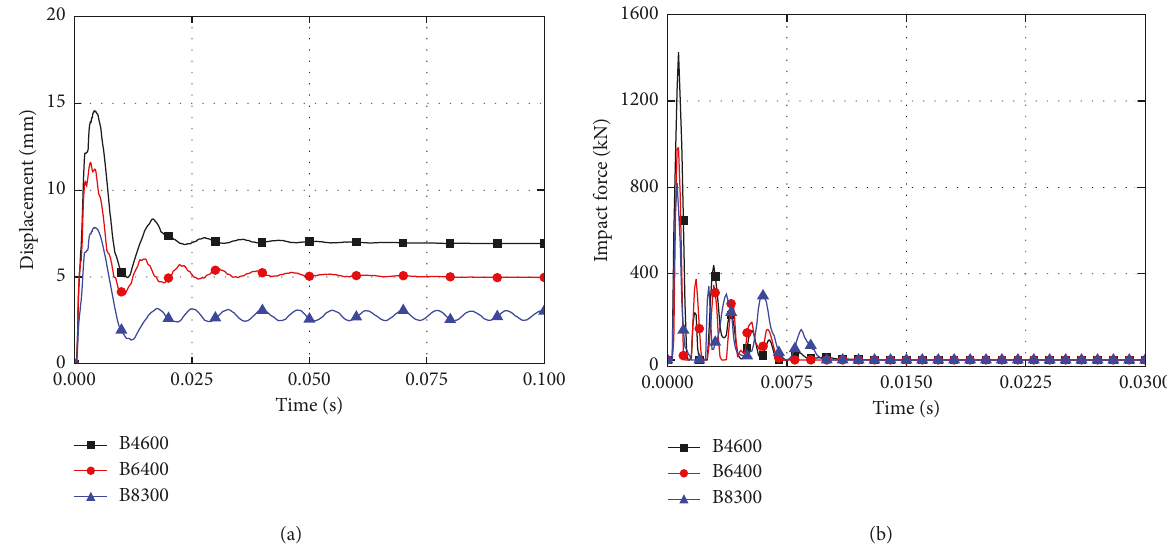
Figure 16: Comparison of impact response (constant impulse). (a) Comparison of midspan displacement. (b) Comparison of impact